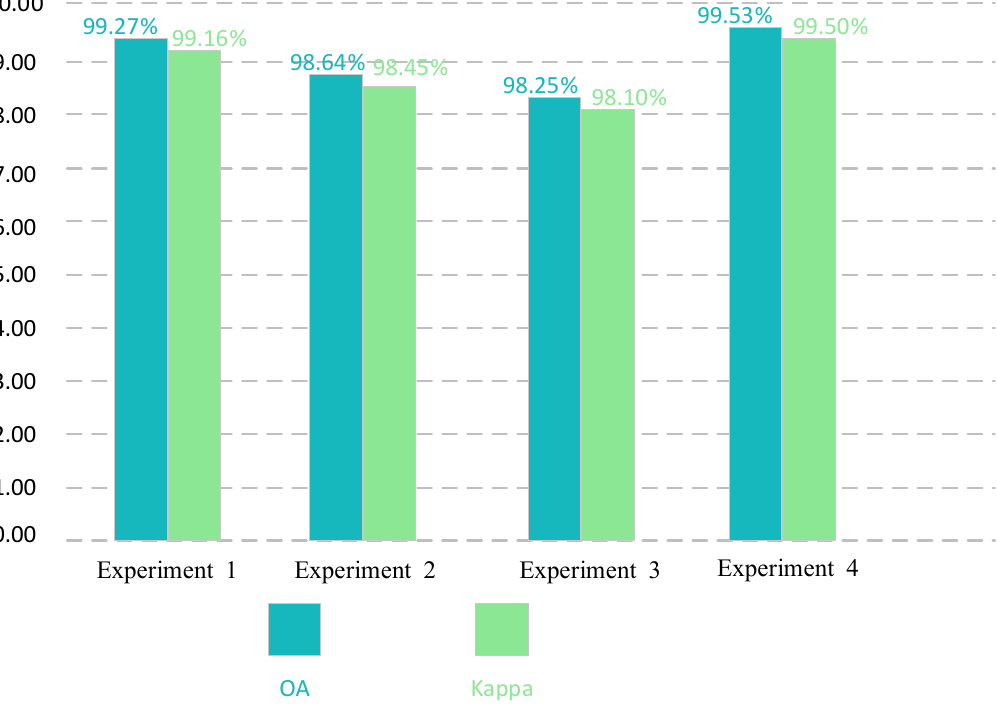
Figure 17. Comparison of OA and kappa values between dimension-wise convolution and traditional convolution on UC dataset with training ratio of 80%.